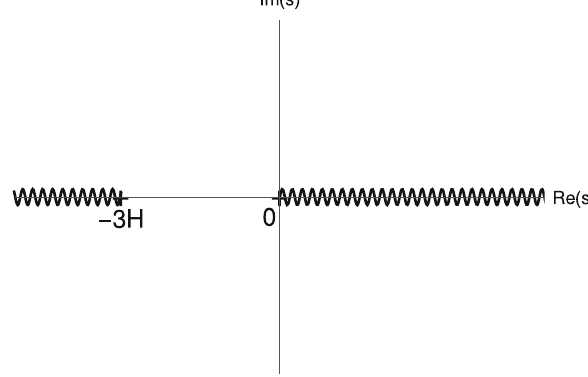
Fig. 2 Example of branch cuts starting at s = − 3 H and at the origin s = 0 and extending to the infinity